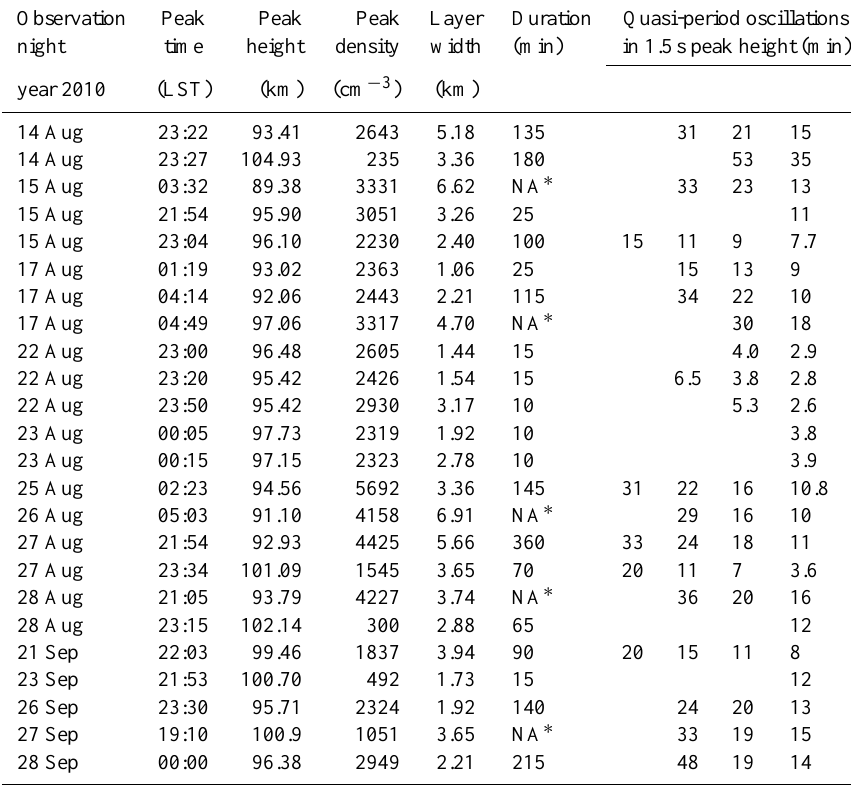
Table 2. The peak height variation of these 24Na s layer events. Observation Peak Peak Peak Layer Duration Quasi-period